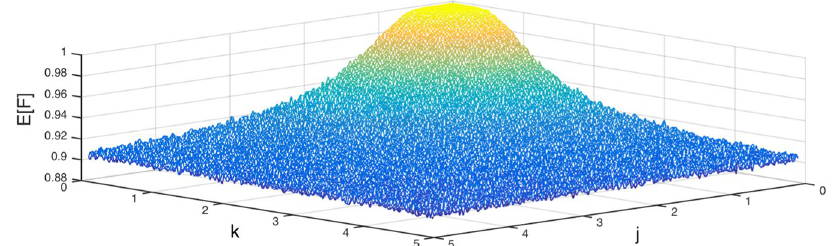
Figure 4. Average fidelity as a function of both J and K for a system of size 8. The number of disorder realizations for each disorder amplitude J and K is 10 4 . Under these dynamics, E[ F ] decays substantially within a certain range of the (J , K ) parameter space and then gradually tends towards